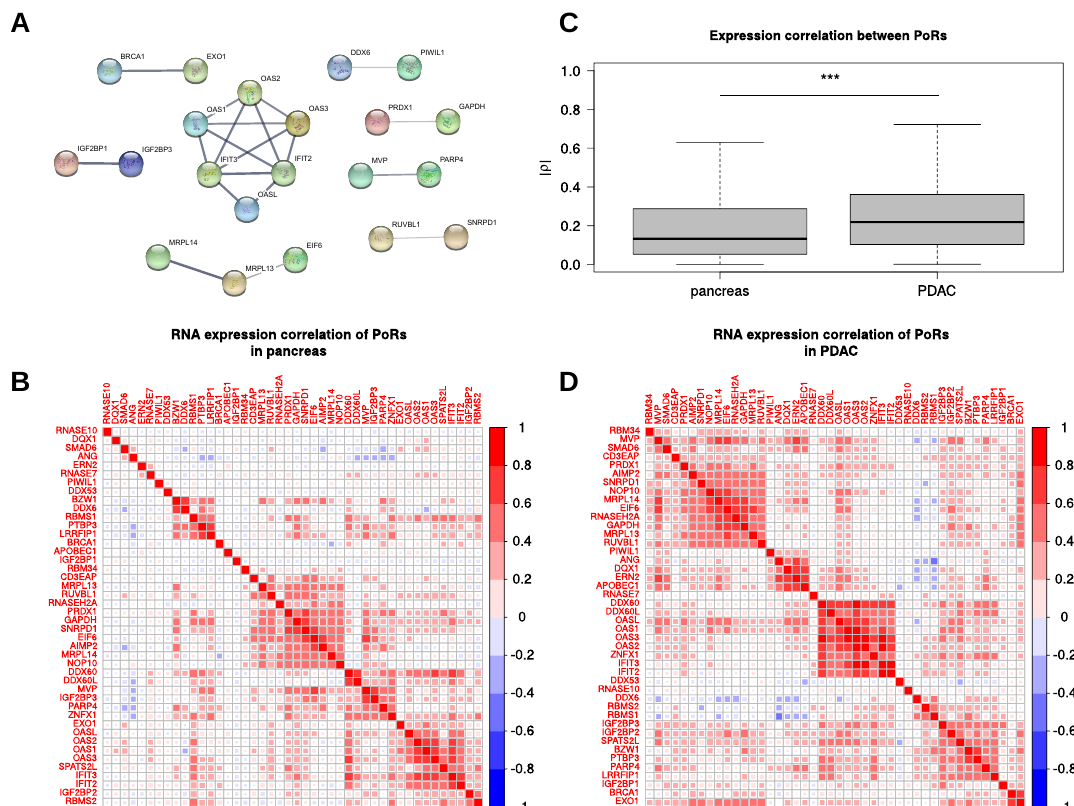
Figure 4. PoR interactions. ( A ) Known physical interactions between PoRs according to the STRING database. ( B , D ) Spearman’s correlation coefficients of the PoR RNA expression in pancreas ( B ) and PDAC ( D ) RNA-seq samples. ( C ) Distribution of Spearman’s correlation coefficient magnitudes ( | ρ | ) obtained from comparisons among the 44 PoRs in pancreas and PDAC RNA-seq